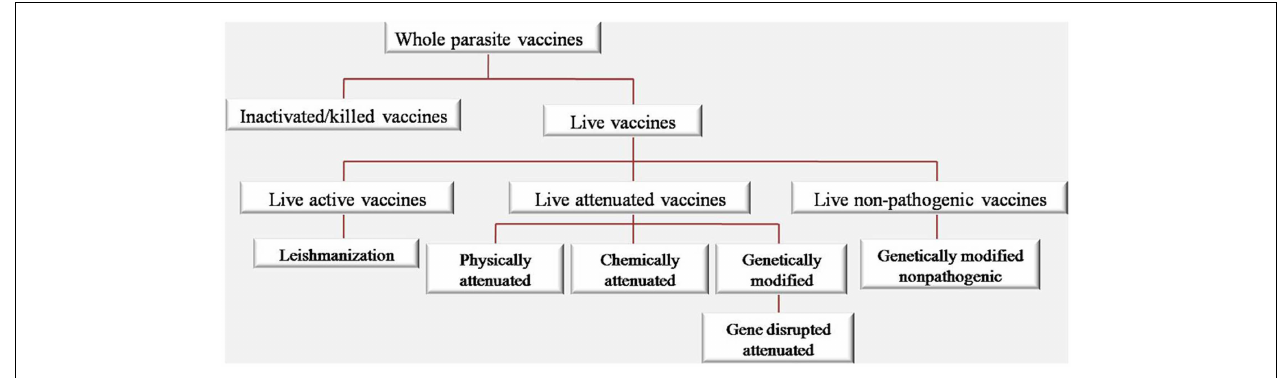
FIGURE 2 | Categorization of vaccine types based on whole Leishmania parasite